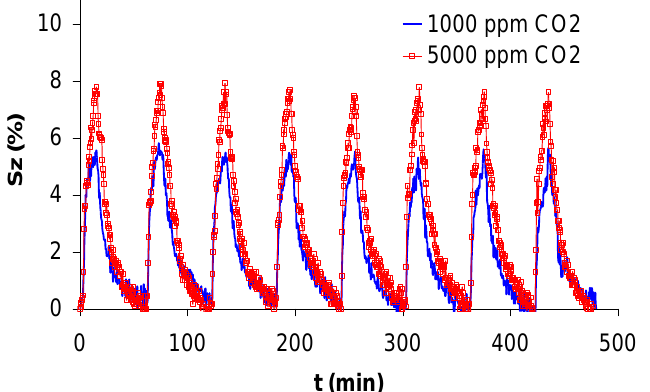
Figure 9. Comparison of eight consecutive pulses of two different concentrations of CO measured at 300  C and 40%